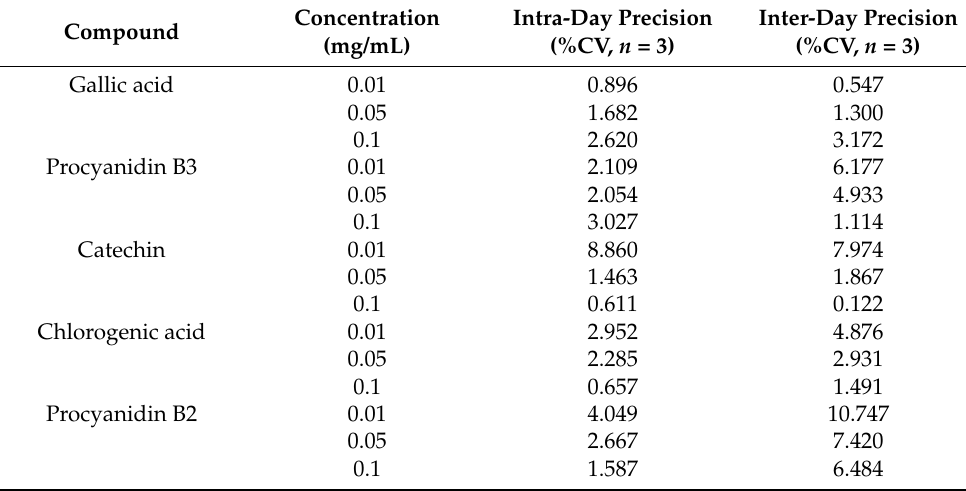
Table 3. Intra-day and inter-day precision of the representative compounds of Annurca apple polyphenolic